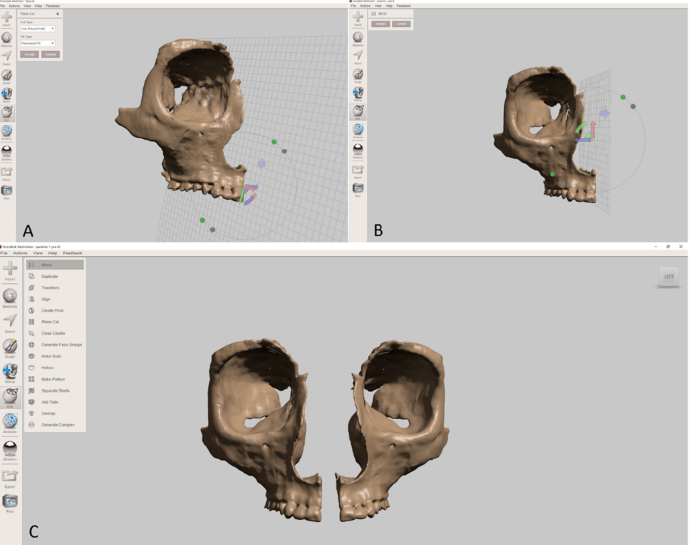
Figure 3. Meshmixer software digital workflow. ( A ) Manual segmentation of the affected orbit; ( B ) mirroring process; ( C ) final mirrored healthy orbit.